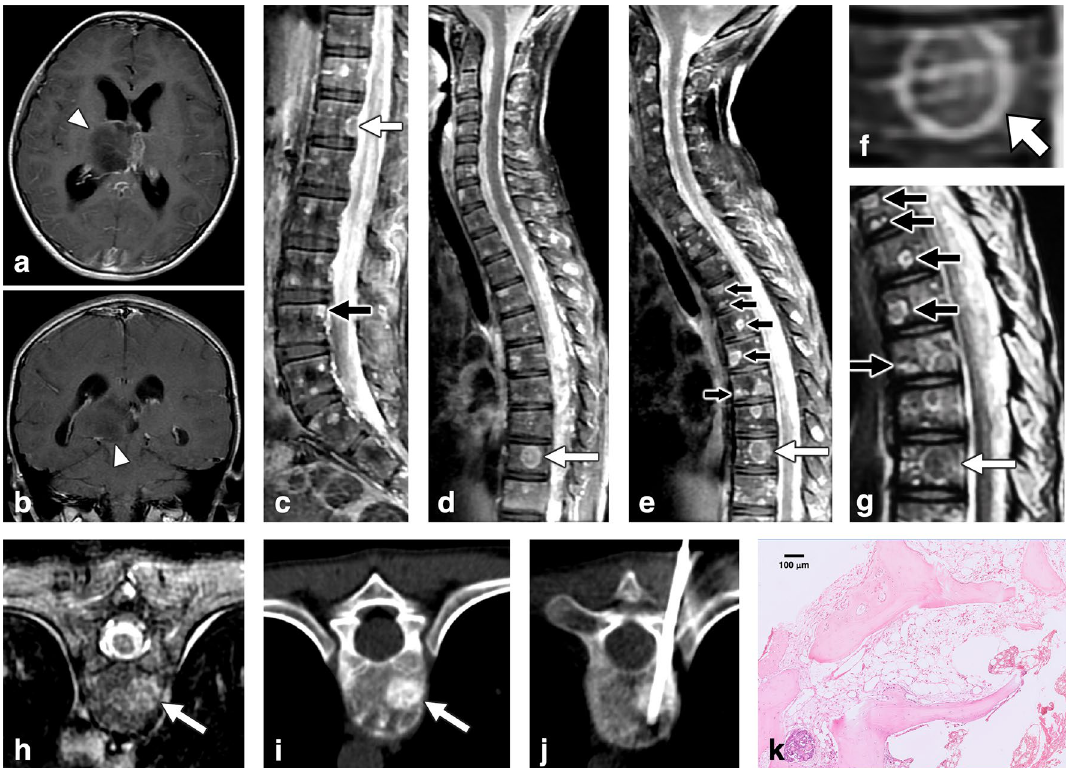
Figure 1. Indolent enhancing spinal lesion (IESL)—Case 1. An 11-year-old girl with anaplastic astrocytoma (2016 WHO grade III) over the right thalamus ( a , b ) was treated with partial tumor removal, radiotherapy, and chemotherapy. Four months after the surgery, sagittal contrast-enhanced T1WI revealed diffuse leptomeningeal seeding and multiple enhancing lesions over the whole spine ( c , d ). Target enhancement ( d , arrow), ring enhancement ( c , white arrow) and corner involvement ( c , black arrow) were present. In the follow-up MRI 6 months after brain tumor surgery, sagittal contrast-enhanced T1WI of the cervical to middle thoracic spine revealed progression of the lesions ( e ). A target-enhancing pattern was specified at the T10 level ( d , e , white arrow; magnified in f ), which appeared hypointense on T2WI ( g , white arrow). Coexisting lesions with ring enhancement on T1WI ( e , black arrow) and hyperintensity with a “double line sign” on T2WI were also noted ( g , black arrow). The T10 target-enhancing lesion on axial contrast-enhanced T1WI ( h ) revealed osteoblastic changes on CT scan ( i ). The first CT-guided biopsy disclosed no histologic evidence of malignancy ( j ). One week later, the second CT-guided biopsy revealed hypocellular marrow tissue and bone dust (H&E staining) ( k